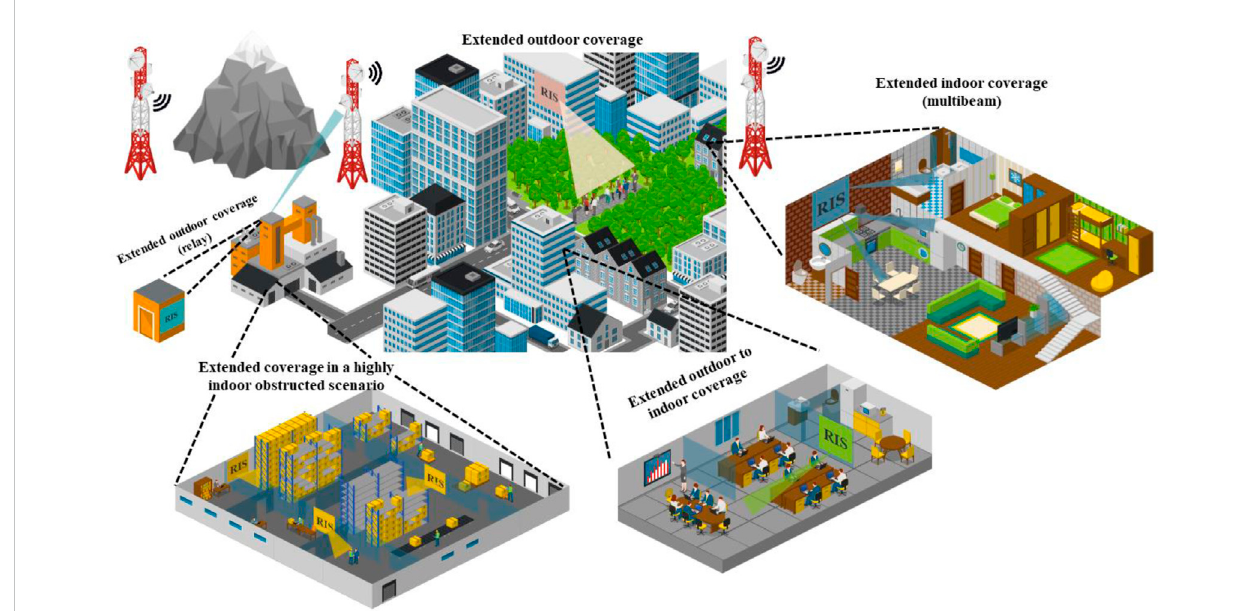
FIGURE 5 RIS application scenarios for coverage improvement.